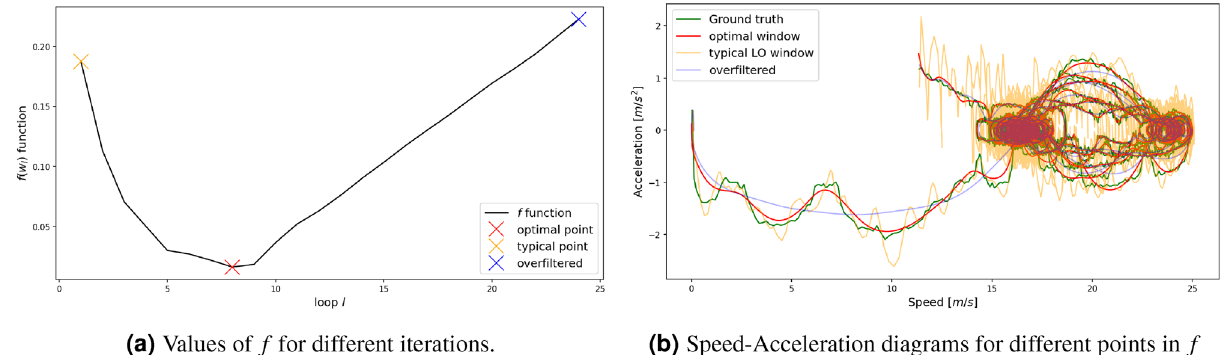
Figure 6. Example of f function over the number of iterations for the LO method with.